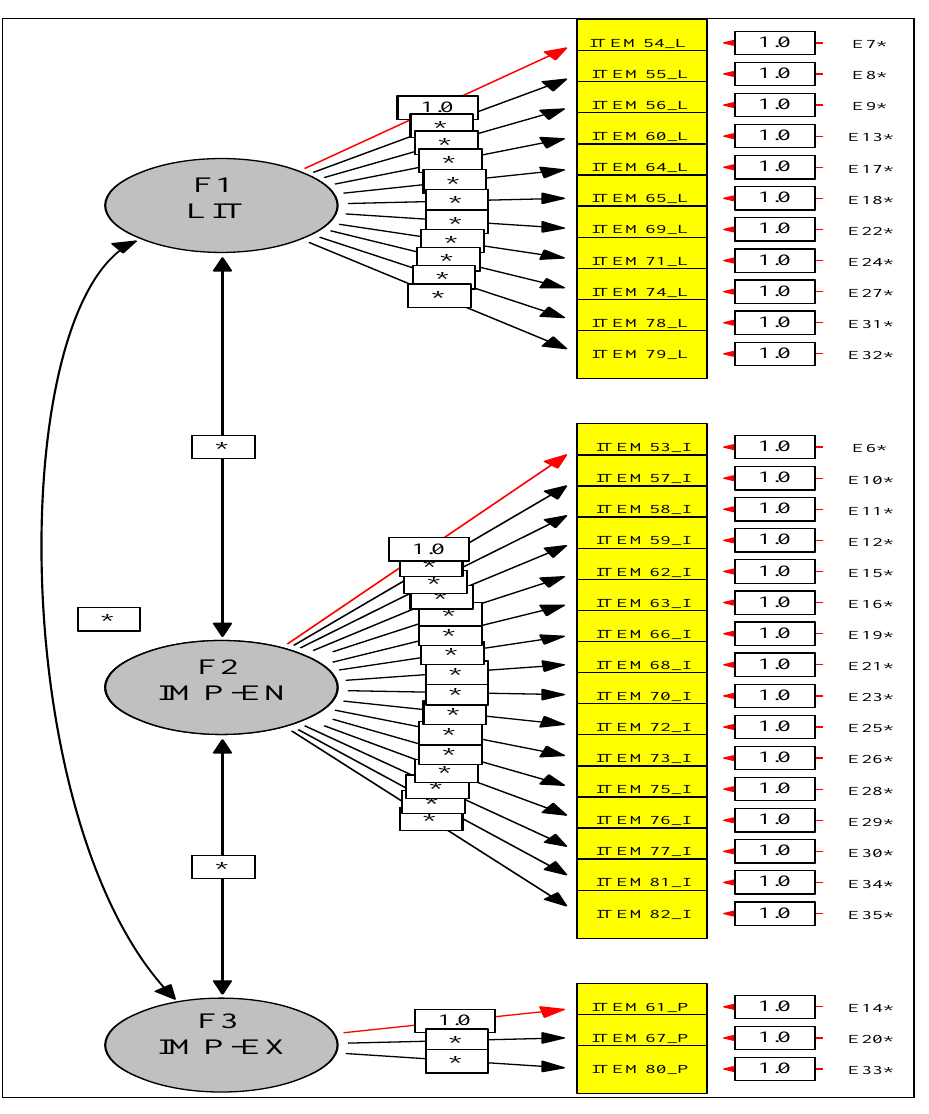
Initially Hypothesized 3-trait Model of Reading